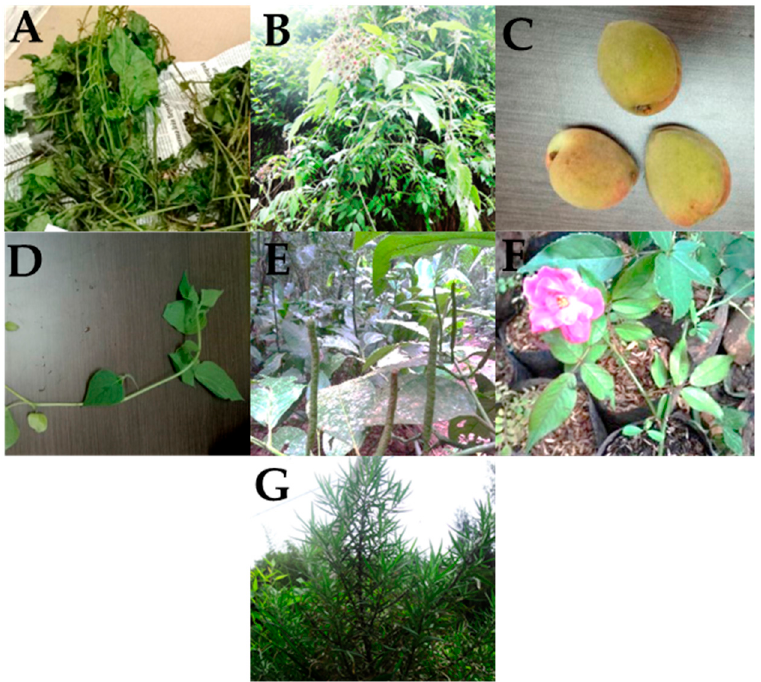
Figure 4. Pictures of understudied medicinal plants used by the Indigenous people of Tengger. ( A ): Cayratia clemaidea ; ( B ): Drymocallis arguta : ( C ): Elaeocarpus longifolius ; ( D ): Physalis lagascae ; ( E ): Piper amplum , ( F ): Rosa tomentosa ; ( G ): Tagetes tenuifolia .